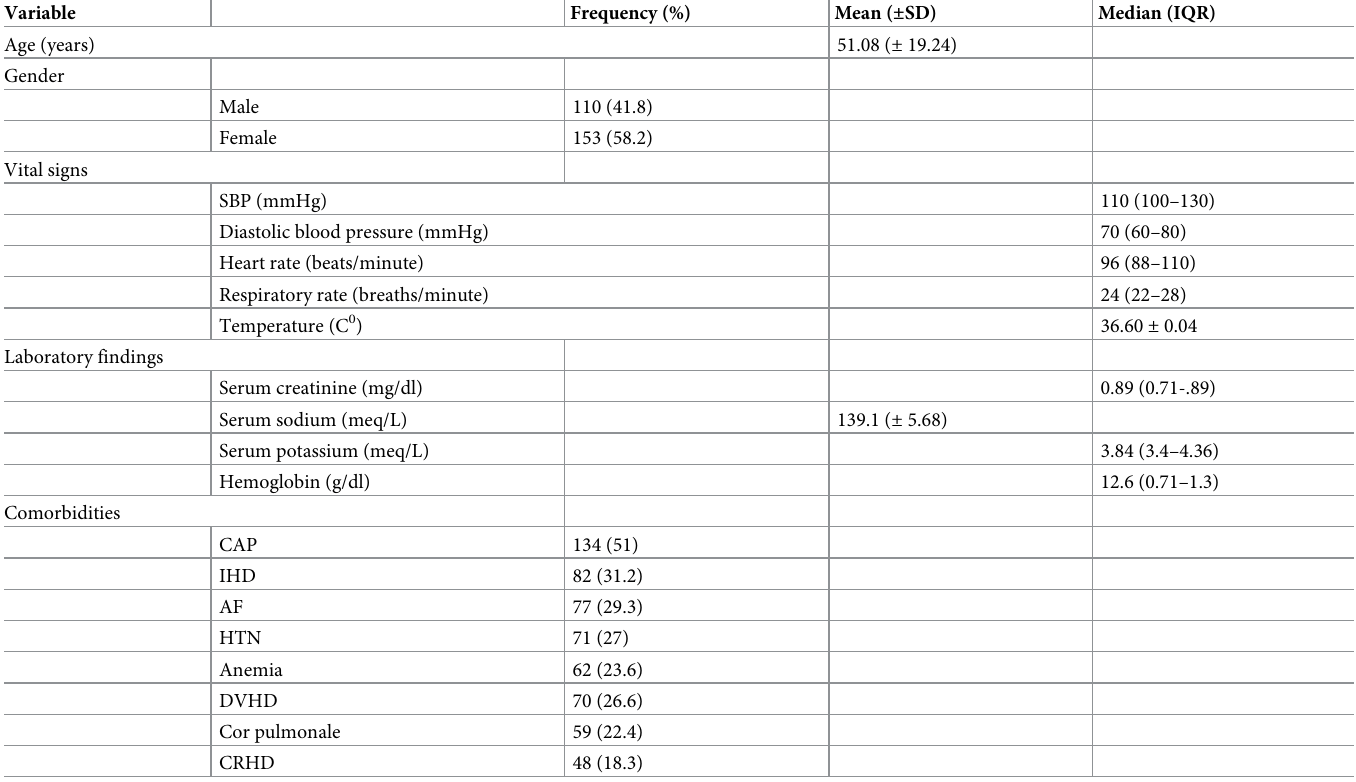
Table 1. Socio-demographics and clinical characteristics of HF patients admitted at UOGCSH medical ward.